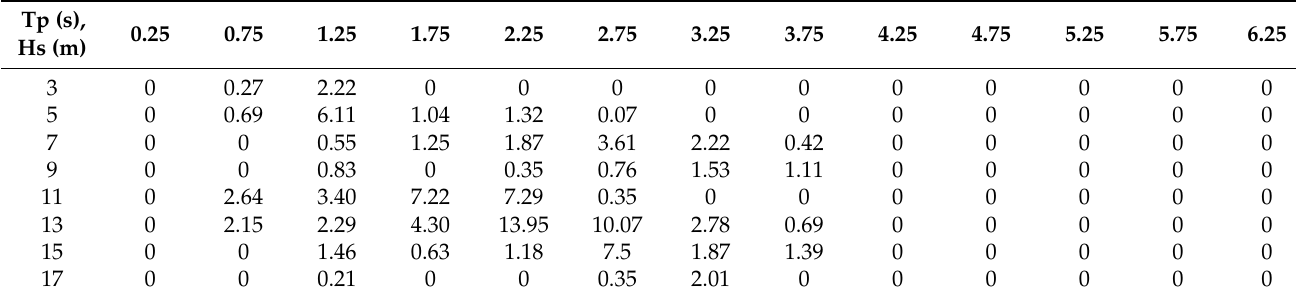
Table A3. Probability density (%) of waves according to significant wave heights (Hs) and peak time periods (Tp) for November 2009 at Orkney